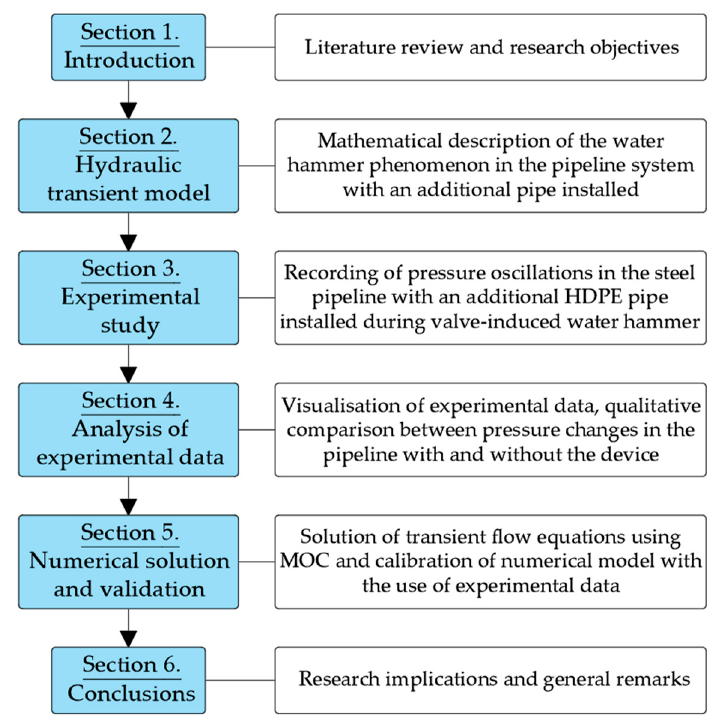
Figure 1. Research flowchart.